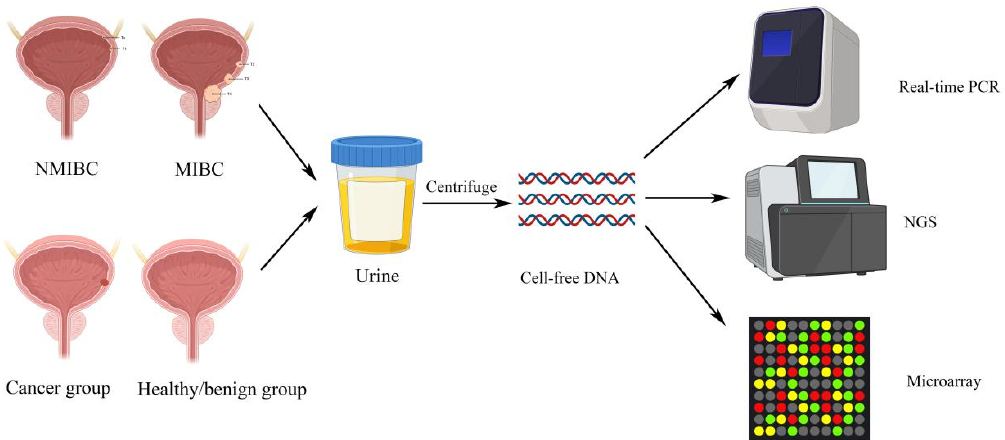
Figure 2. Studies reported that there existed a significant difference of the urinary cell-free DNA between bladder cancer patients and healthy or benign groups. By real-time qPCR and next-generation sequencing, we can accurately test the amount of ucfDNA, thus achieving non-invasive detection of bladder cancer. Which means we have a chance to discriminate bladder cancer patients from healthy group, even differentiating bladder cancer patients of different subtypes, thus achieving early detection of primary and recurrent patients. Table 1. Summary of different parameters and techniques and potential markers in urinary cell-free DNA (ucfDNA) for bladder cancer detection, monitoring, and surveillance.